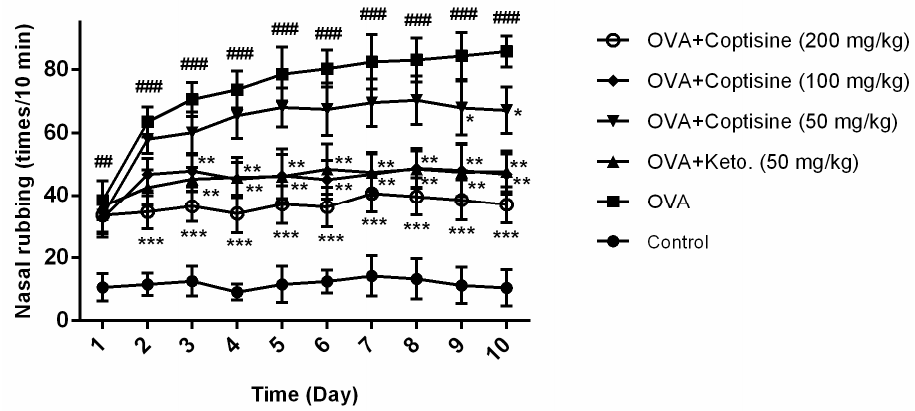
Figure 7. Effect of coptisine on the number of nasal rubbing in OVA induced AR mice. Counting the number of nasal rubbing in the ten min after OVA intranasal injection. All data were expressed as the mean ± SE. ### p < 0.001, ## p < 0.01 were compared to the control group; * p < 0.05, ** p < 0.01 and *** p < 0.001 were compared to AR mice, n =